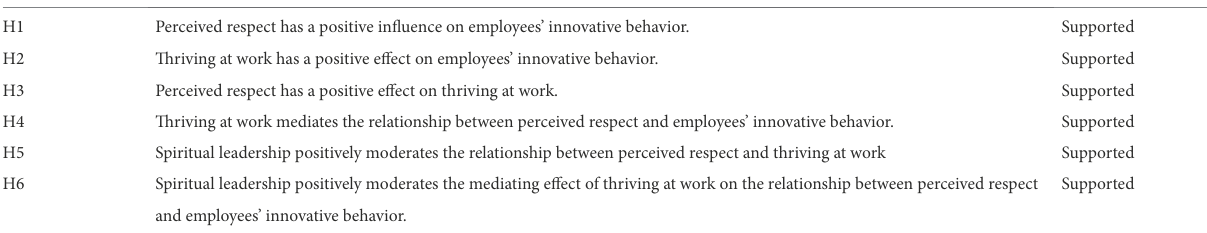
TABLE 5 Hypothesis test